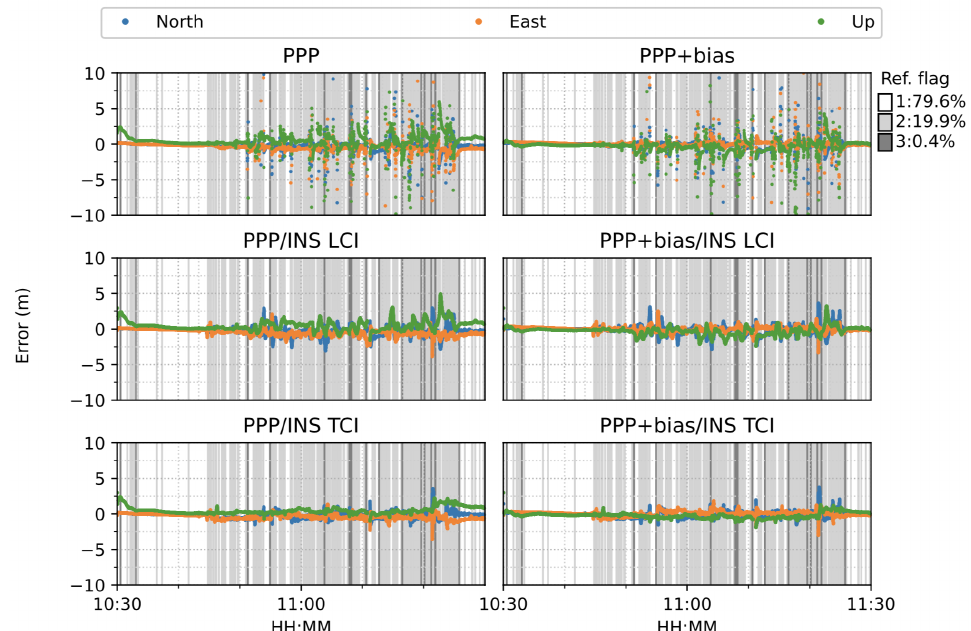
Figure 16. GPS/Galileo PPP/INS results of complex road test on 11 February 2022. Different background color indicates different quality or flag of reference solutions (Ref. flag in the figure). The same